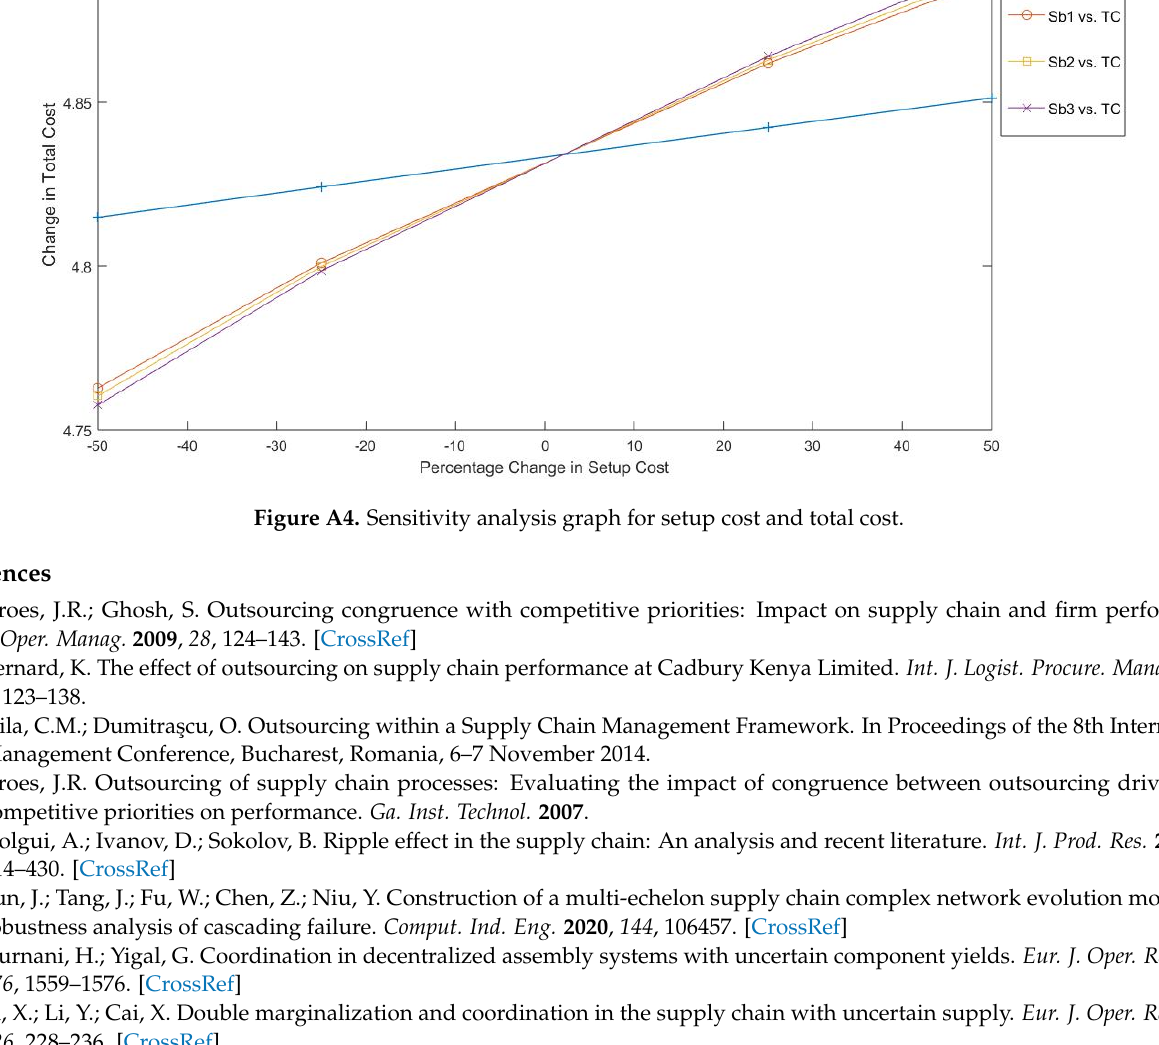
Figure A3. Sensitivity analysis graph for holding cost and total cost.